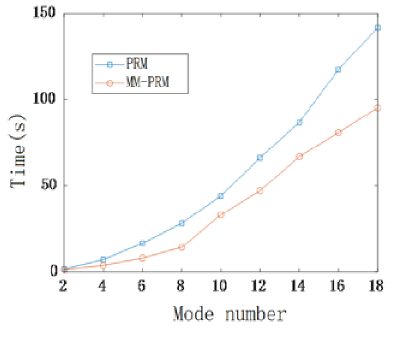
Fig. 2. Runtime of PRM and MM-PRM in different